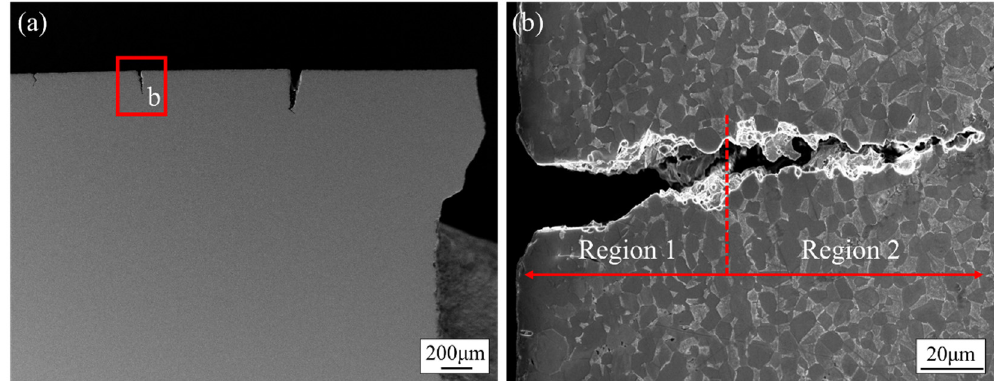
Figure 9. SEM image of the longitudinal section near the tensile fracture of PO60 specimen: ( a ) the macro image, ( b ) the microscopic image of the corresponding area in ( a ).